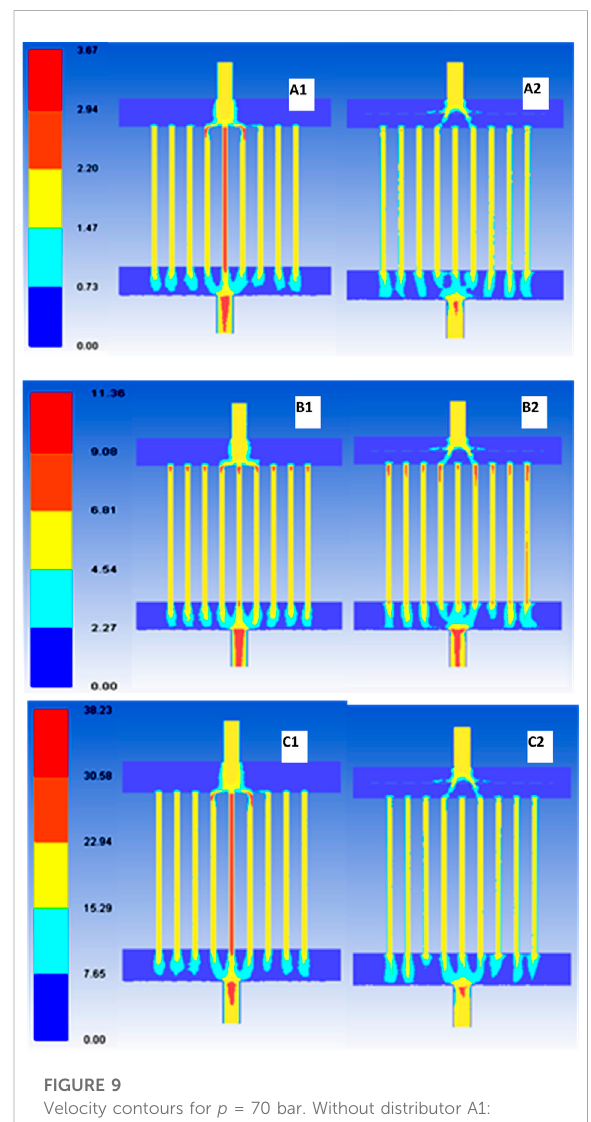
FIGURE 9 Velocity contours for p = 70 bar. Without distributor A1: Reynolds number (Re) = 2.82E+05; B1: Re = 9.86E+05; C1: Re = 2.82E+06. WithdistributorA2:Re=2.82E+05;B2:Re=9.86E+05; C2: Re = 2.82E+06 (all units of velocity are given in m/s for the color